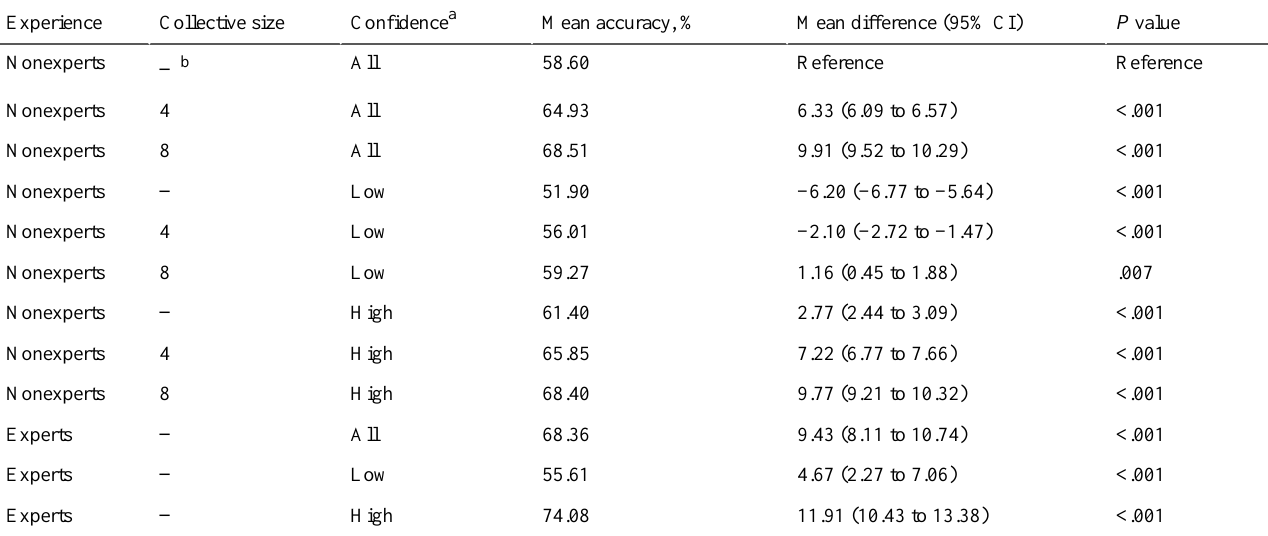
Table 1. Comparison of mean accuracy of single nonexperts to mean accuracy of different collective sizes and confidence levels. P values denote paired t test comparing the number of correct specific diagnoses per overlapping dermatoscopic